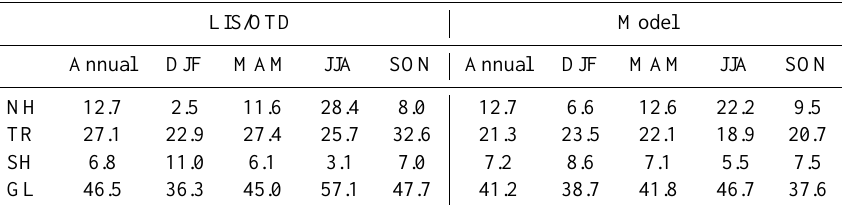
Table 1. The annual and seasonal total flash rate (in flashess − 1 ) estimated from the LIS/OTD high-resolution monthly climatology (HRMC) data (Cecil et al., 2014) and the model simulation for the Northern Hemisphere (NH, 20–90 ◦ N), the tropics (TR, 20 ◦ S–20 ◦ N), the Southern